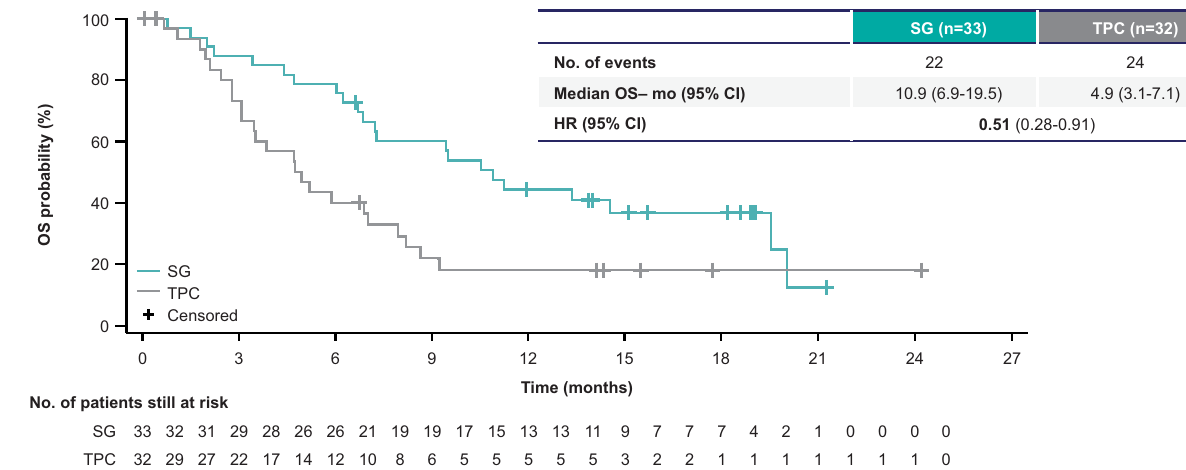
Fig. 2 Overall survival in the second-line subgroup. Assessed in the brain metastasis-negative population. Second-line patients were de fi ned as those who received one line of therapy in the metastatic setting and recurred ≤ 12 months after (neo)adjuvant chemotherapy, prior to study enrollment. HR hazard ratio, (neo)adjuvant neoadjuvant or adjuvant, OS overall survival, SG sacituzumab govitecan, TPC treatment of physician ’ s choice.